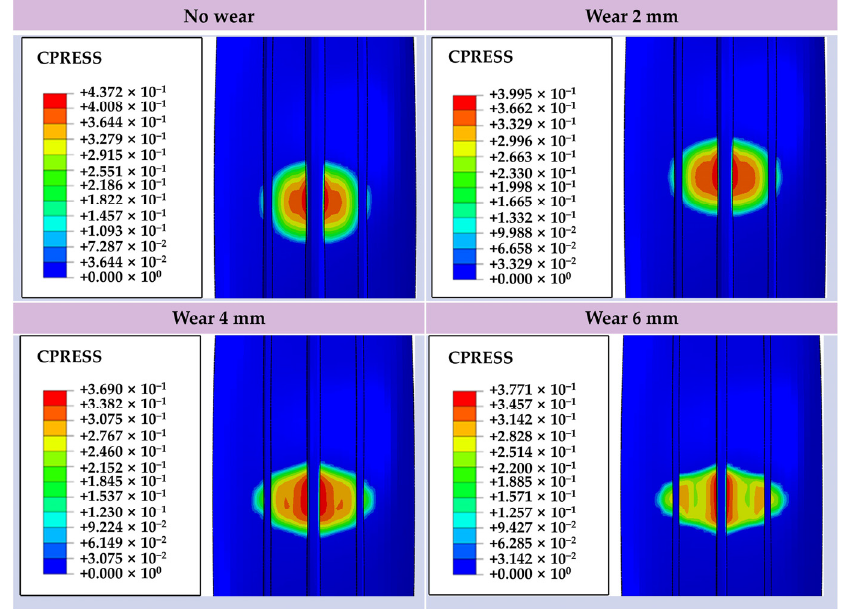
Figure 21. Contact pressure distribution of tire longitudinal contact patch under different wear